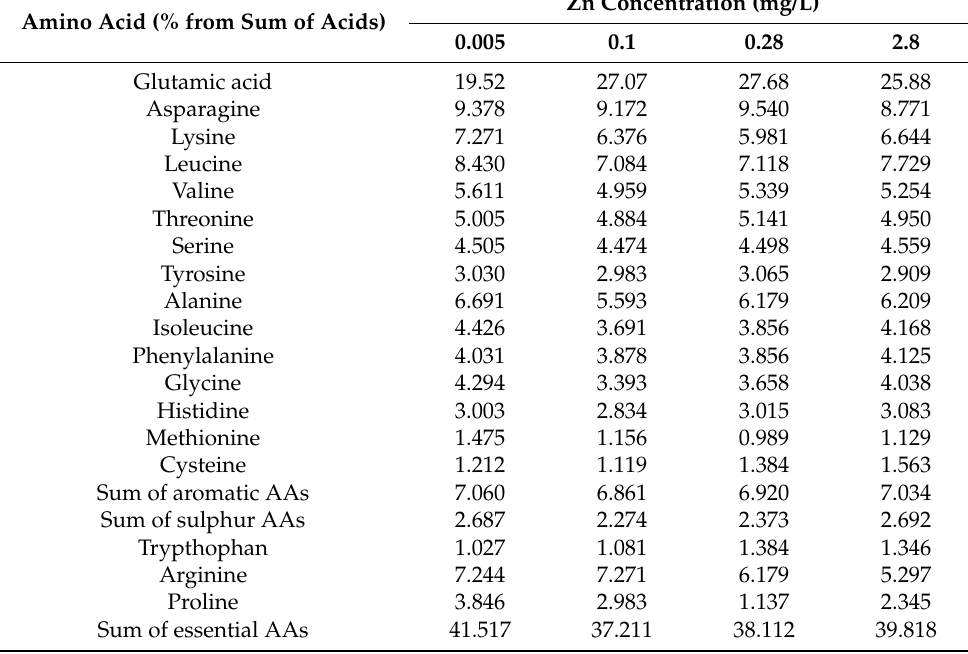
Table 4. Amino acid content of T. globosa biomass. Amino Acid (% from Sum of